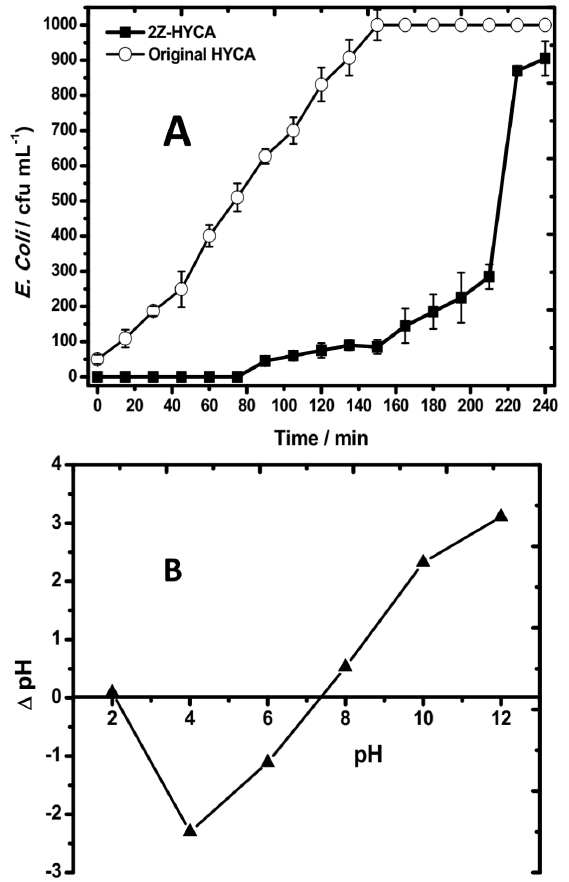
Figure 10: (A) Bacterial load ( E. coli ) vs treatment time measured in water treated with a fixed bed process for both the original HYCA ma- terial and the new 2Z-HYCA@650 °C material. The initial E. coli con- centration was 10 3 cfu/mL; (B): The pH pzc plot for 2Z-HYCA@650 °C. that will be electrostatically held onto the positive sites on the surface of the